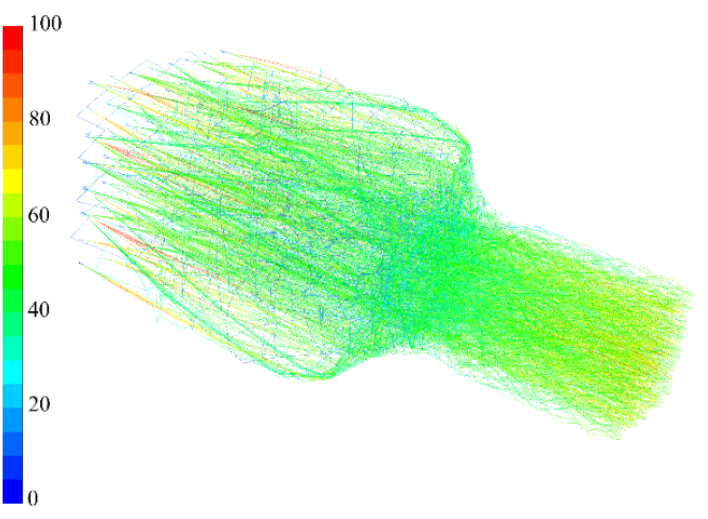
Figure 13. Trajectory and velocity of particles (m/s).